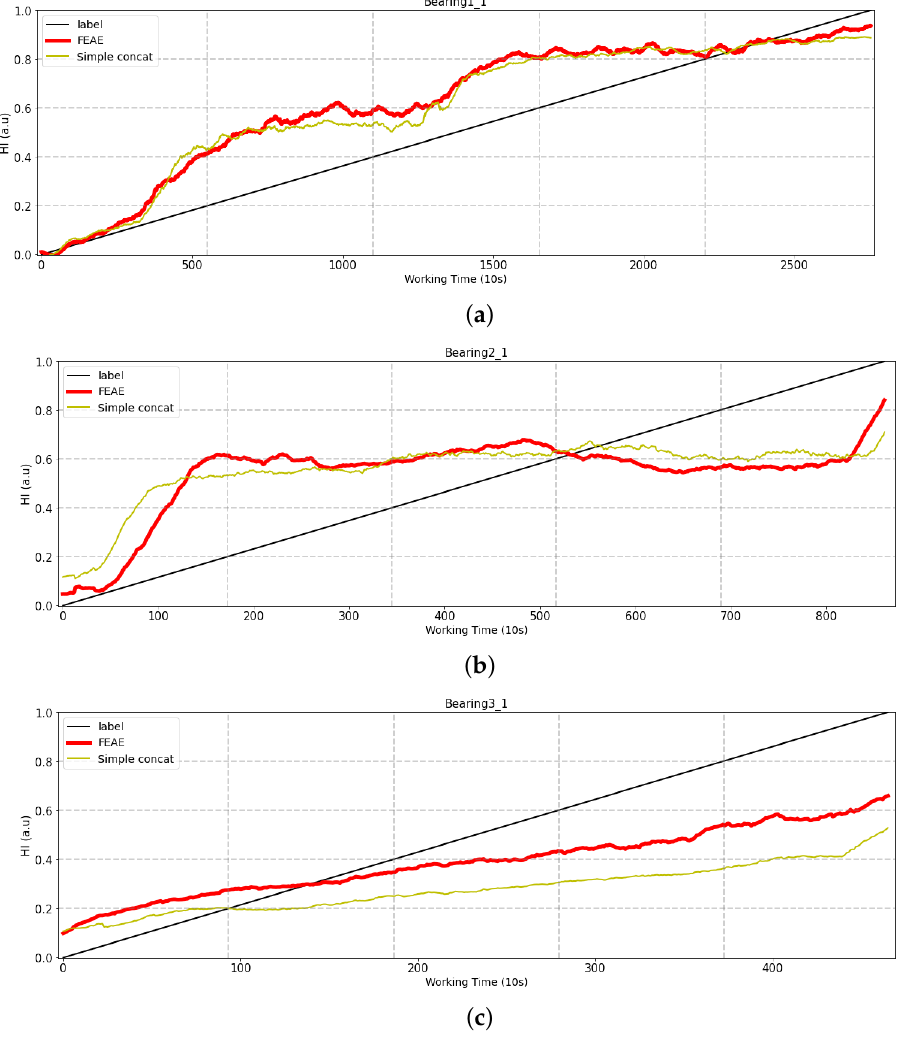
Figure 12. Comparison of experiment results of simple concatenate models. ( a ) Test bearing1_1, ( b ) Test bearing3_1, ( c ) Test